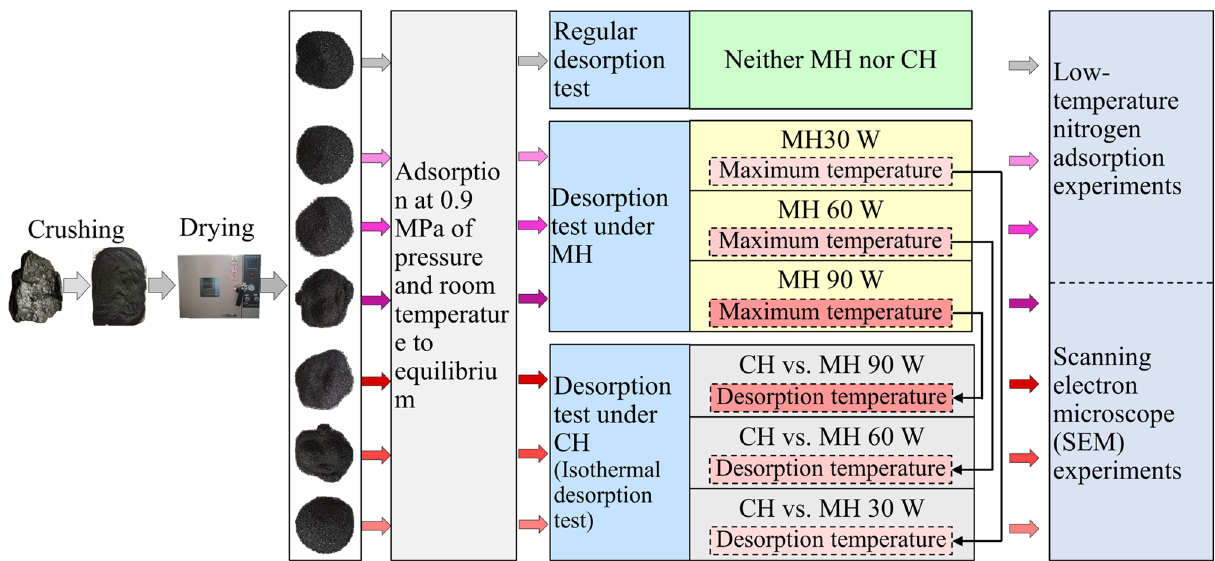
Figure 1. Flow chart showing desorption test experimental procedures.